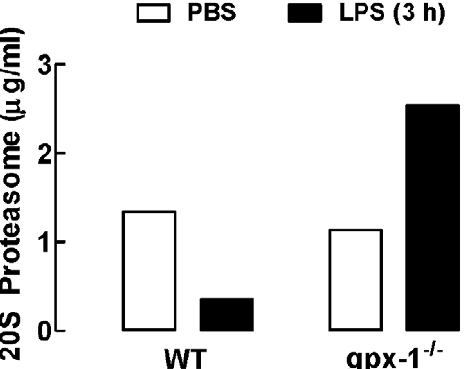
Figure 6. Effect of LPS on 20S proteasome concentrations in BALF of WT and gpx-1 2 / 2 mice. WT and gpx-1 2 / 2 mice were treated with LPS (10 m g/mouse) for 3 h and 20S proteasome concentrations measured in BALF. Data are shown as the mean for BALF pooled from 5–6 individual mice per treatment group. Clear bars represent PBS-treated mice and black bars represent LPS-treated mice.